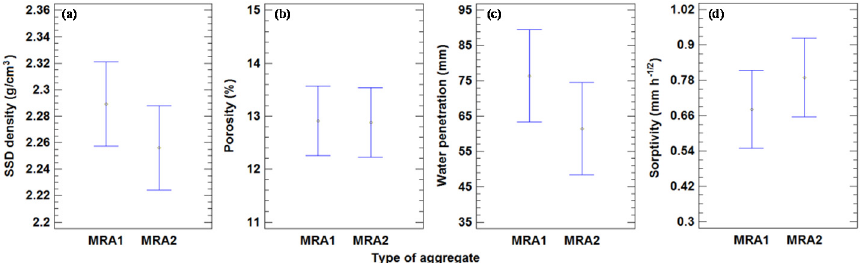
Figure 14. ( a ) Mean values of SSD density and 95% LSD intervals vs. type of MRA. ( b ) Mean values of porosity and 95% LSD intervals vs. type of MRA. ( c ) Mean values of water penetration and 95% LSD intervals vs. type of MRA. ( d ) Mean values of sorptivity and 95% LSD intervals vs. type of MRA.